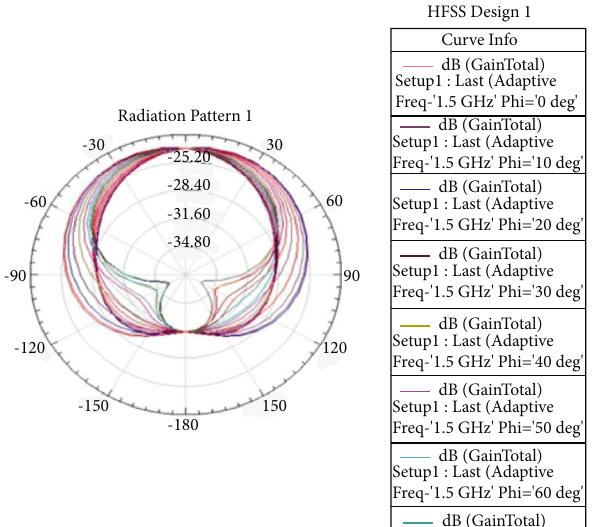
Figure 10: Radiation pattern 1 of designed circular patch